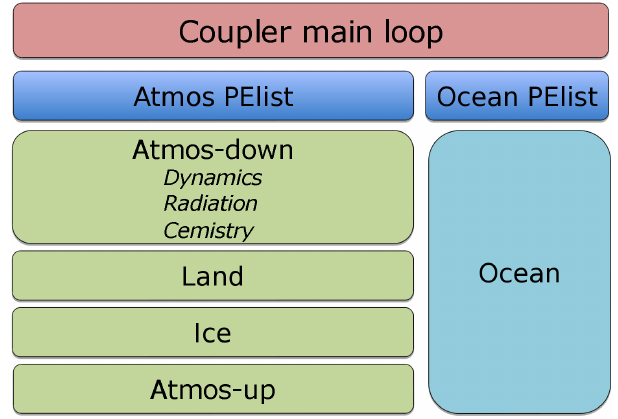
Figure 3. FMS parallel coupling architecture in processor–time space, with processors across, and time increasing downward. Com- ponents have different horizontal and vertical extents to indicate the degree of parallelism and time of execution, though these extents are notional and not to be interpreted as drawn to scale. Within a single executable for the entire coupled system, the atmosphere and ocean components run concurrently in distributed memory (MPI, indicated in deep blue). Within the atmosphere stack, components execute serially, including tight coupling to the land and ice–ocean surface. The down-up sequence of implicit coupling is explained in Balaji et al. (2006). These components internally use shared- memory (OpenMP) coupling, indicated in light green. The ocean component at the present time is MPI only, indicated in light